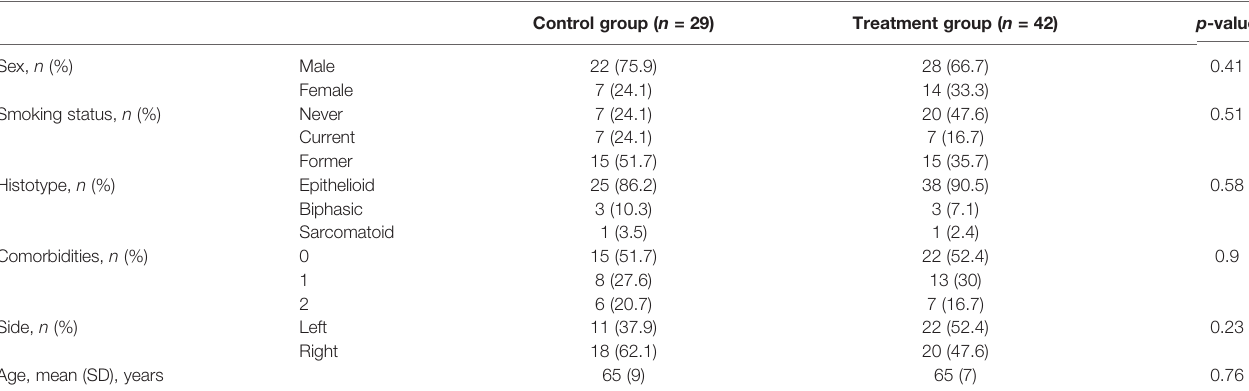
TABLE 1 | Clinicopathological characteristics of patients divided in control and treatment